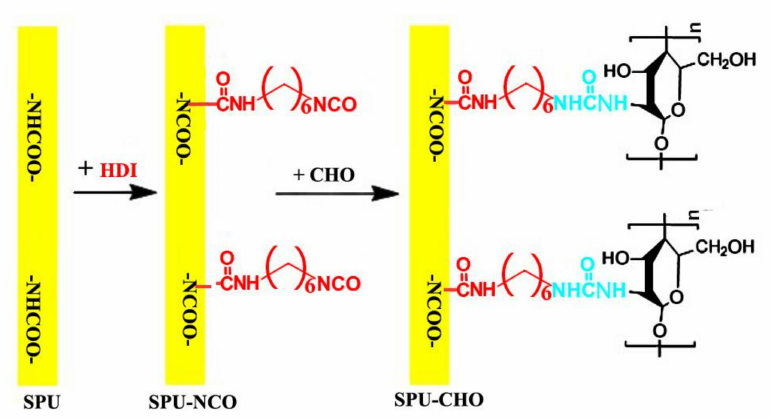
Figure 1. The surface-grafted CHO onto SPU